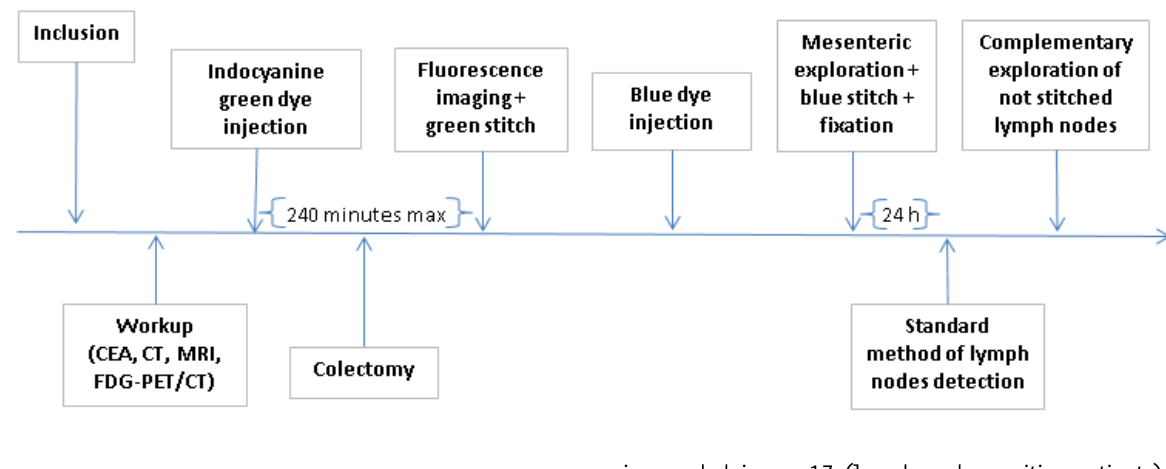
Figure 2. Flowchart of the study. CAE: carcinoembryonic antigen; CT: computed tomography; FDG-PET/CT: 18-Fluoro-deoxy-glucose positron emission tomography with computed tomography; MRI: magnetic resonance